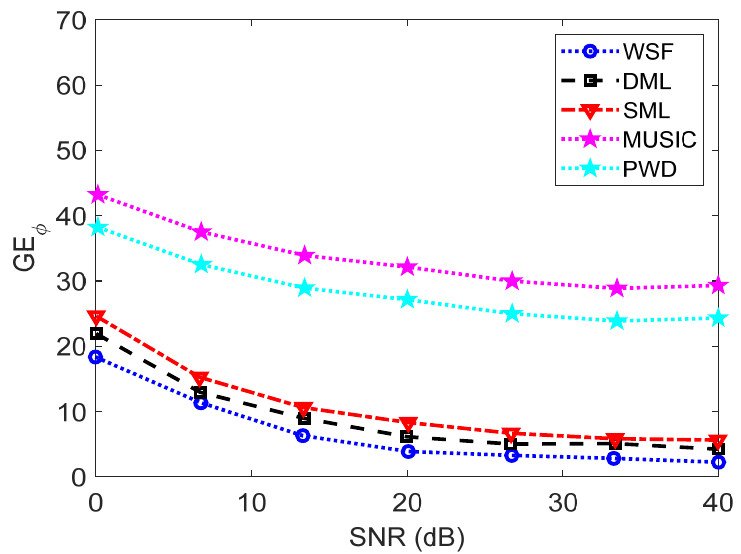
Figure 7. GE performance evaluation of MUSIC, PWD, DML, SML, and WSF against SNR using the measured data in